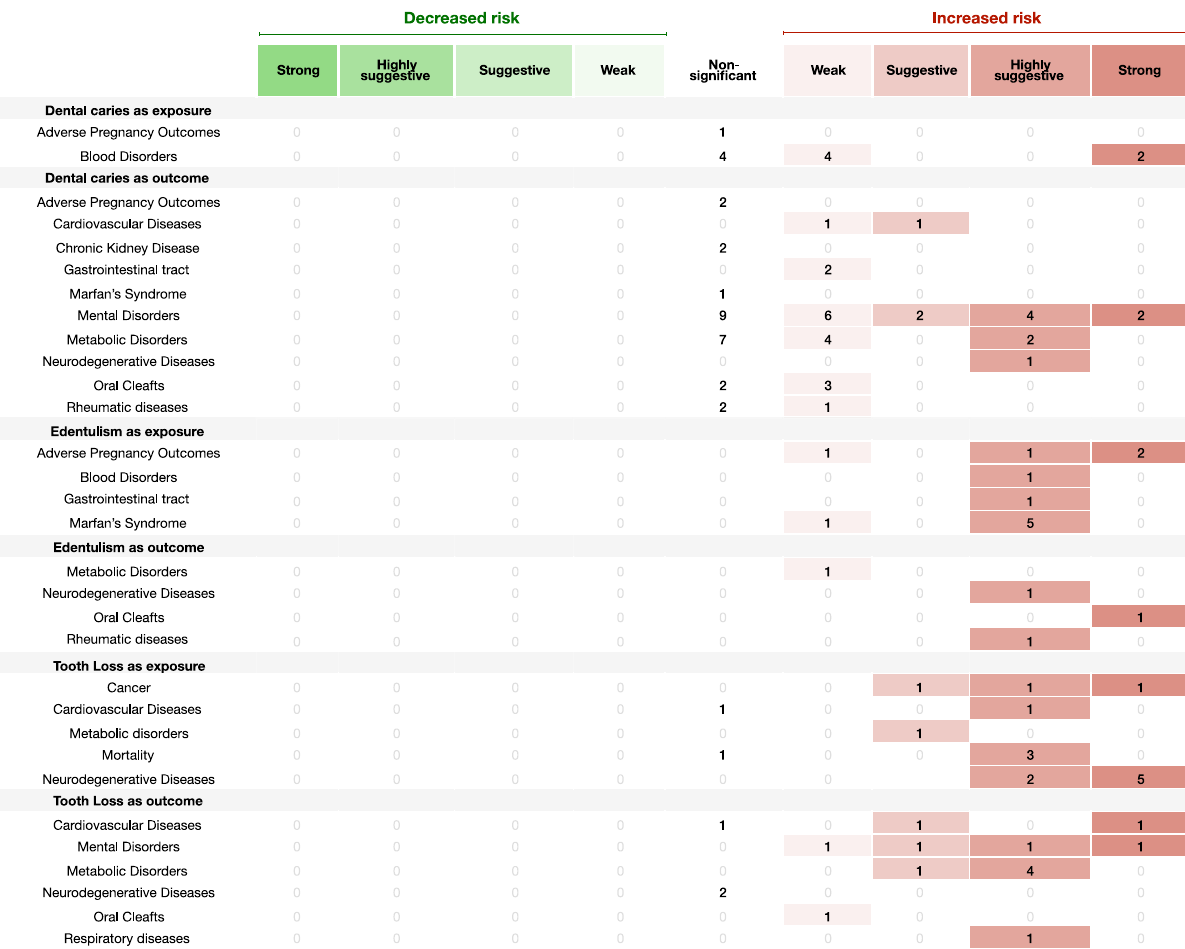
associations that reduce the risk (in green). APO adverse pregnancy outcomes, CVDs cardiovascular diseases, CKD chronic kidney disease, Dis. disease. Source data are provided as a Source Data fi